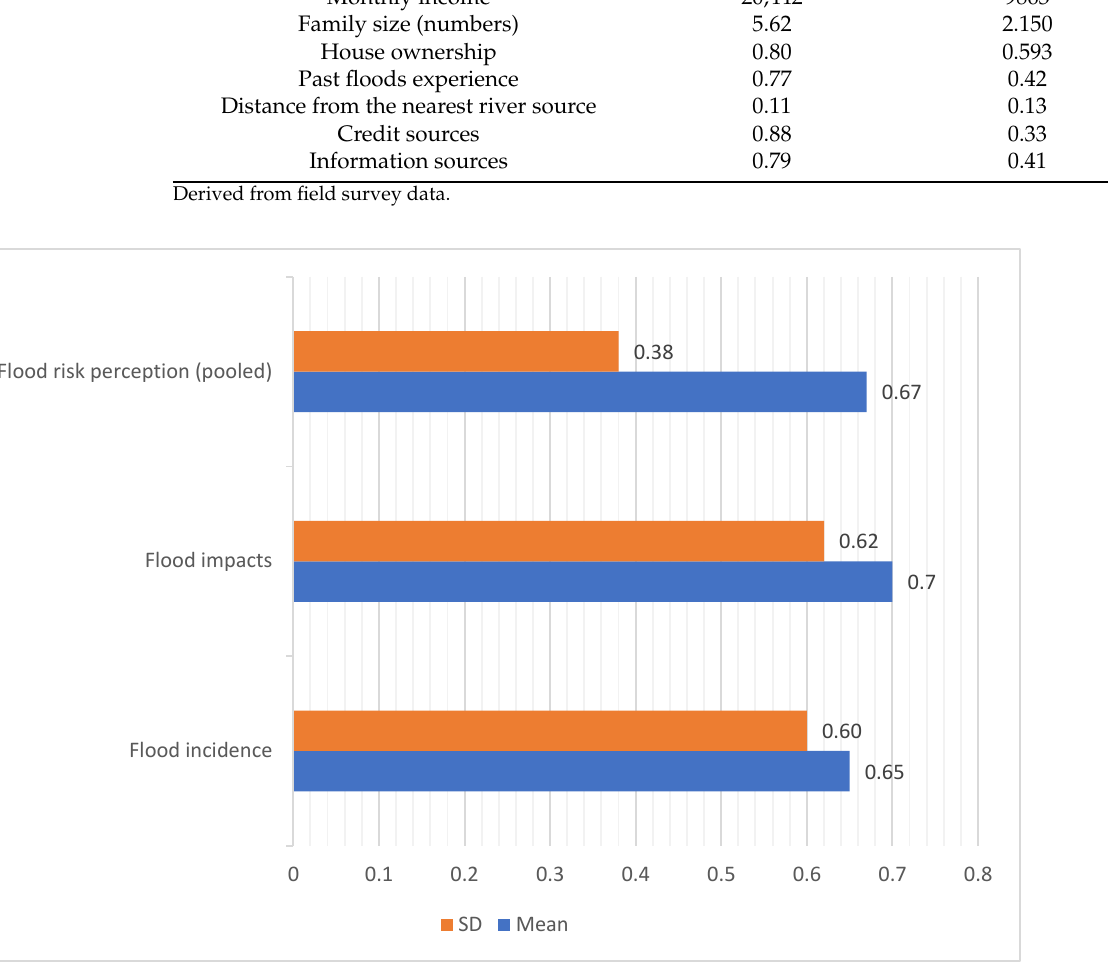
Figure 3. Flood risk perception/incidence and impacts.